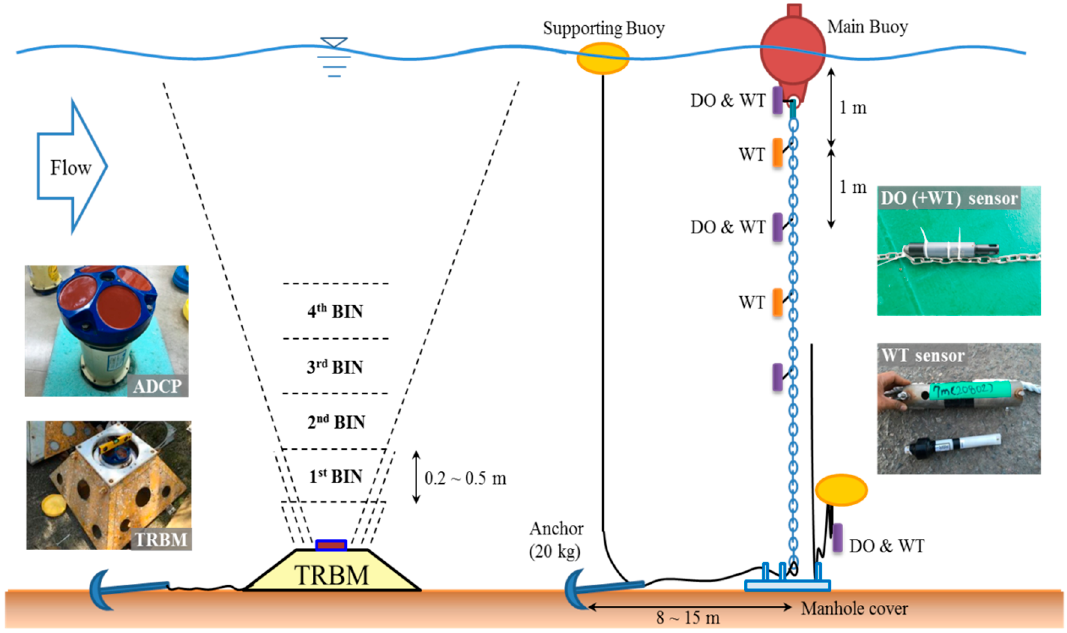
Figure 2. Installation of the water temperature gauge and acoustic Doppler current profiler (ADCP). The TRBM is the trawl-resistant bottom mount.